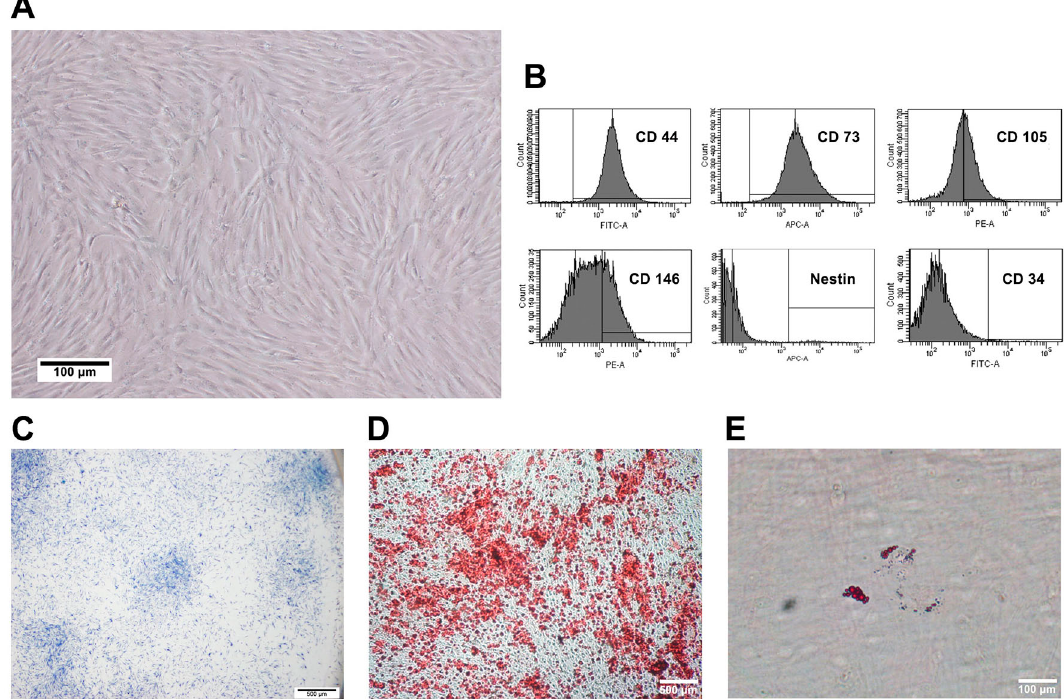
Figure 1- The isolated cells from human permanent teeth exhibited mesenchymal stem cell characteristics and were defined as DPSCs. (A) A light microscopic image of the cells showing fibroblast-like shape. (B) Flow cytometry analysis shows expressions of CD44, CD73, CD105, CD146, Nestin, and CD34 of the cells. (C) Colony-forming unit-fibroblast assay of the isolated cells under a light microscope. (D) Alizarin red staining of osteogenic differentiated cells as indicated by red mineralized nodules. (E) Adipogenic differentiation of the cell observed by oil red O lipid droplets